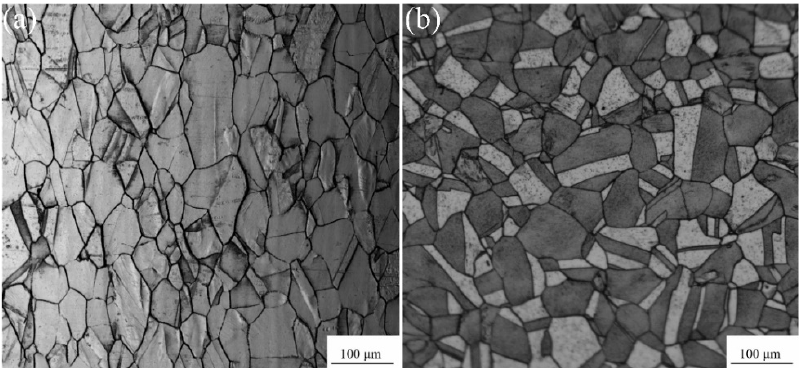
Figure 1. Microstructure of CuNi 2 Si alloy obtained by etching: ( a ) Along longitudinal direction; ( b ) Along transverse direction.